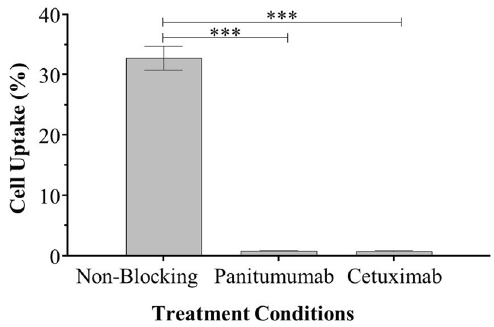
Figure 1. Cellular uptake of 89 Zr-panitumumab in EGFR expressing SCC cells. Percent of administered activity detected in SCC-1-luc+ with and without blocking with unlabeled EGFR antibodies (***p <